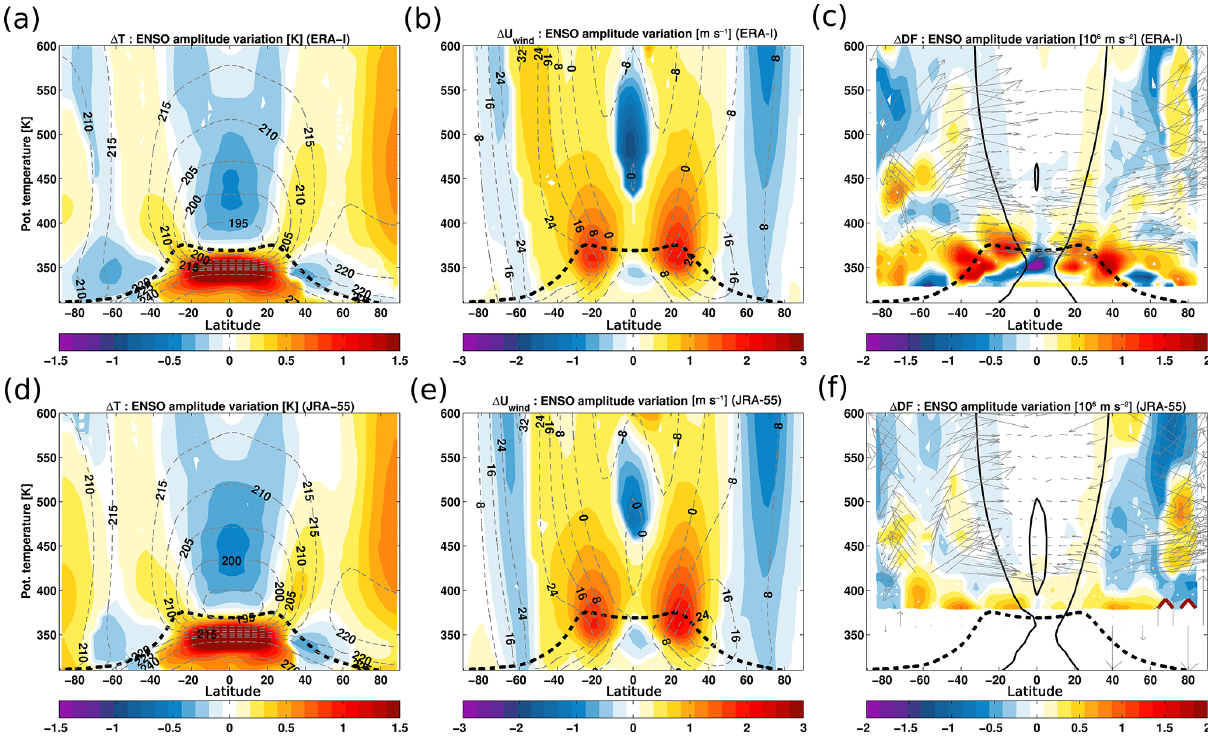
Figure 9. Zonal mean distribution of the ENSO impact on monthly mean temperature (K), zonal wind (ms − 1 ), and EP flux and its divergence (ms − 2 ) derived from (a–c) ERA-I and (d–f) JRA-55 reanalyses. The amplitude of the temperature, zonal wind, and EP-flux variations (term b 2 × SD ( MEI ) ) attributed to the ENSO events is calculated by projecting the regression fits onto the ENSO basis functions for the 1979–2013 period. Black dashed horizontal line indicates the climatological tropopause from ERA-I and JRA-55 reanalyses. Zonal mean climatologies are overplotted as dashed grey lines. The thick black line in Fig. 8c, f indicates the zero line zonal mean wind. The arrows indicate the EP-flux